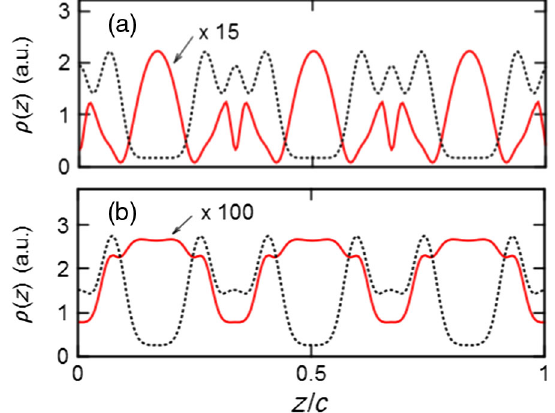
FIG. 4. PED for the energy range from − 0 . 05 to 0.05 eV (solid line) and total valence-electron density (dotted line) for (a) Ca 2 N and (b) Y 2 C averaged over the ab plane (perpendicular to the c axis) in the conventional unit cell [Fig. 2(a)].